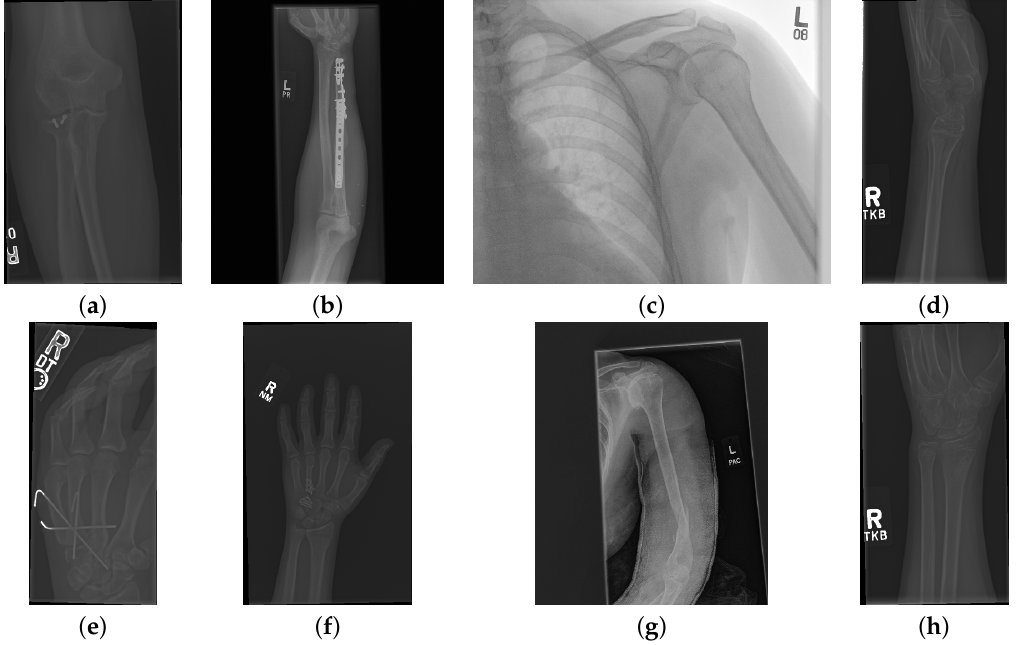
Figure 2. Eight examples of radiographs with abnormalities (considered positive) of the Musculoskeletal Radiographs (MURA) dataset [59]. ( a ) Elbow, ( b ) Forearm, ( c ) Shoulder, ( d ) Wrist (lateral view), ( d ) Lateral view of Wrist, ( e ) Finger, ( f ) Hand, ( g ) Humerus, ( h ) Wrist. As for the cases without abnormalities, it should be noted the variability of the images and in addition the abnormalities themselves. There are cases of metallic implants some of which are smaller ( a ) than others ( b ), as well as